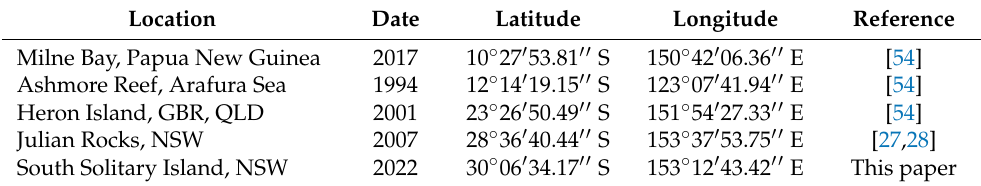
Table 7. Selected distribution records of Nembrotha yonowae from Oceania.